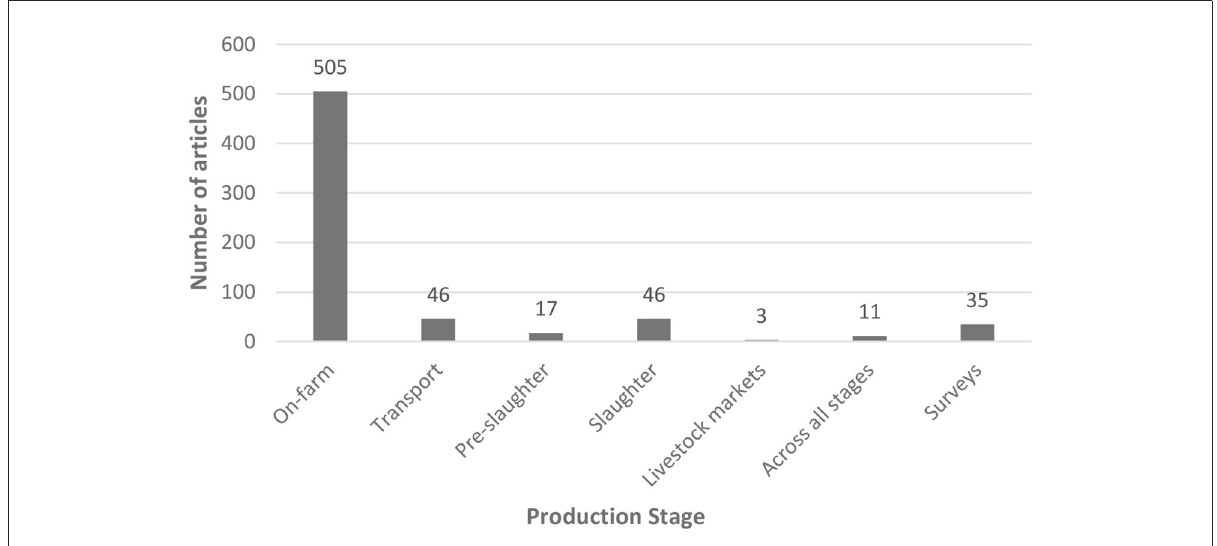
FIGURE4 Production stages considered in the publications on farm animal welfare in Latin American countries between 1992 and 2021 ( n =